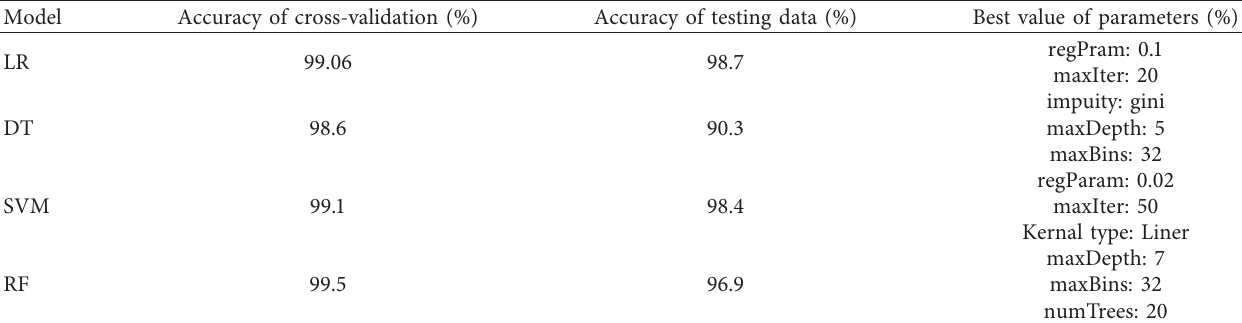
Table 3: The accuracy of 10-fold CV and the accuracy of the unseen dataset after correlation. Model